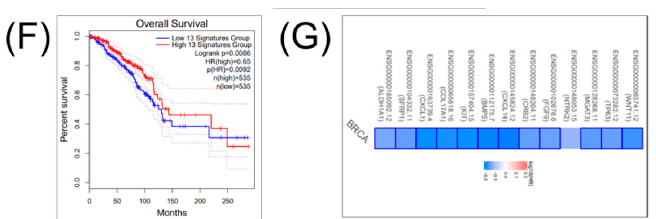
Figure 2. Common cancer stem cells (CSCs) and epithelial-to-mesenchymal transition (EMT) of a downregulated gene expression signature in BRCA. ( A ) A Venn diagram presenting downregulated genes for CSCs and EMT in BRCA (downloaded from NCBI), as well as common signature genes for both CSC and EMT gene lists; bold-lettered genes predict the overall survival. ( B ) An interaction network using String software for a 23-common gene signature involved in both CSC and EMT mechanisms; red-circled genes predict the overall survival outcomes. ( C ) BRCA-altered genes involved in both CSCs and EMT (ALDH1A1 and SFRP1) predicting the overall survival. ( D ) BRCA-altered genes involved only in CSCs (CXCL1, COL17A1, and KIT). ( E ) BRCA-altered genes involved only in EMT (BMP5, CXCL14, CRB2, FGF9, NTRK2, MGAT3, TP63, and WNT11) predicting the overall survival. ( F ) Overall survival rate of a 13-gene signature (ALDH1A1, SFRP1, CXCL1, COL17A1, KIT, BMP5, CXCL14, CRB2, FGF9, NTRK2, MGAT3, TP63, and WNT11). ( G ) A survival map of the selected 13-gene